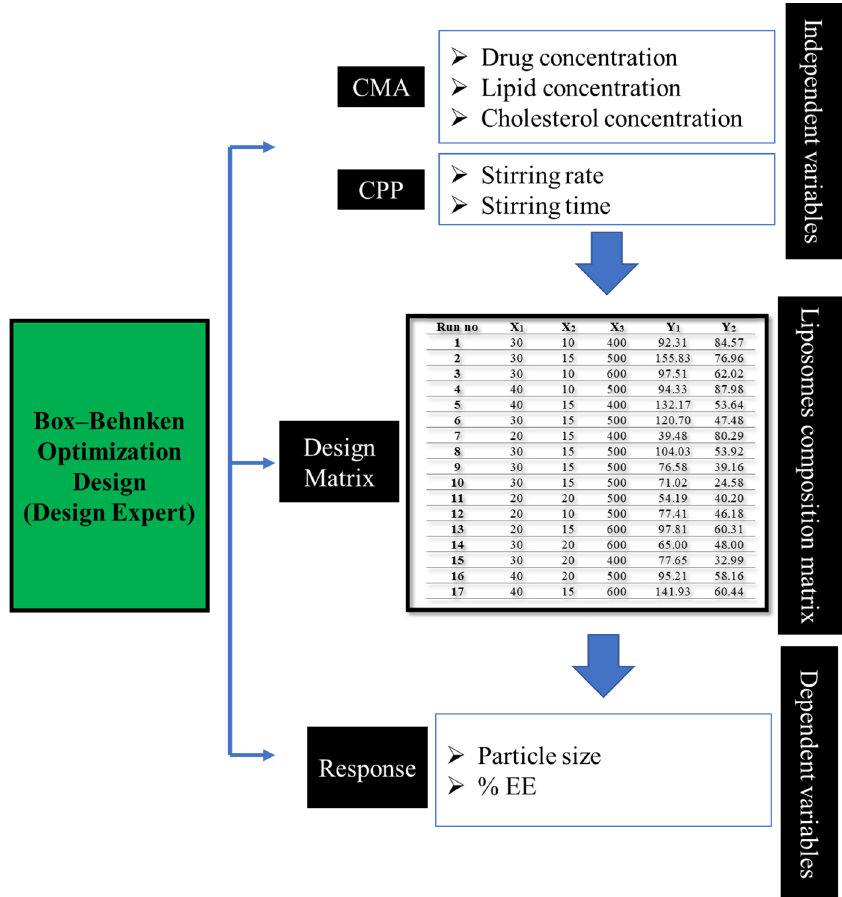
Figure 1. Overview of QbD approach for development of PTH-LPs, where X 1 –X 3 and Y 1 –Y 2 are factors and responses respectively.